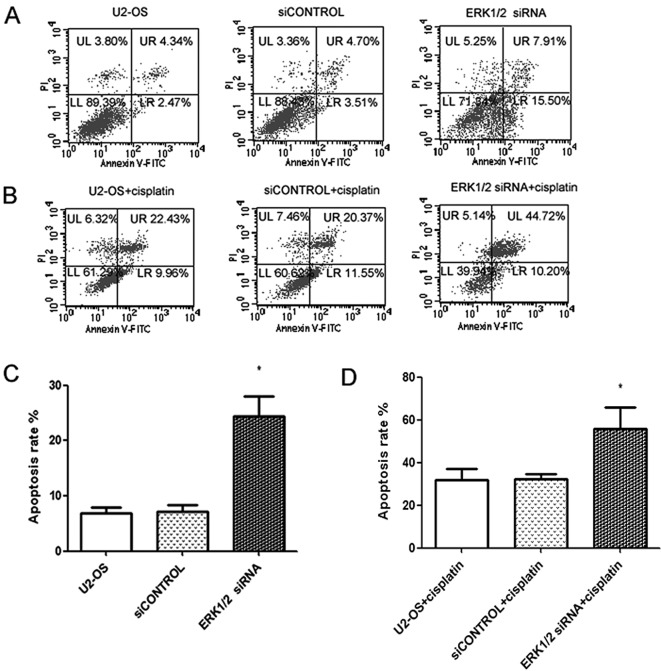
ERK1/2 depletion induces apoptosis and enhances chemosensitivity. (A and C) ERK1/2 inhibition by siRNA caused apoptosis in U2-OS cells. (B and D) ERK1/2 knockdown sensitized U2-OS cells to cisplatin treatment. After 48-h treatment with indicated siRNAs, cells were treated with 10 μg/ml cisplatin for 24 h, and then cells were double stained with annexin V-FITC and PI followed by FACS analysis. FACS analysis scatter-grams of Annexin V/PI staining displays four different cell populations marked as: double negative (unstained) cells showing live cell population (lower left), Annexin V positive and PI negative stained cells showing early apoptosis (lower right), Annexin V/PI double-stained cells showing late apoptosis (upper right), and finally PI positive and Annexin V negative stained cells showing dead cells (upper left). **P<0.01 vs siCONTROL.